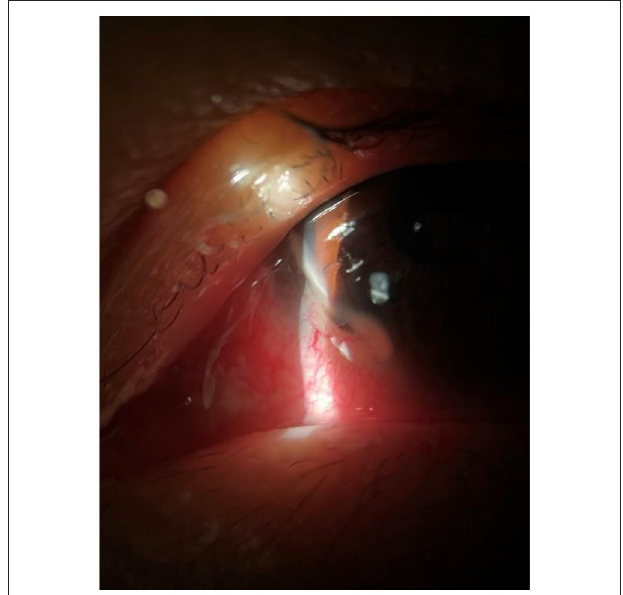
FIGURE 1 | Inferonasal corneal ulceration with adjacent inflammation of the left eye.